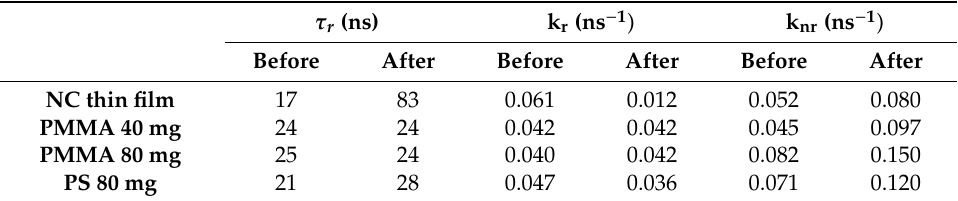
Table 1. Radiative lifetimes ( τ r ), radiative ( k r ) and nonradiative (k nr ) recombination rates, calculated for CsPbBr3 NCs thin film and PMMA- (40 mg and 80 mg load) and PS- (80 mg load) based free standing films before (values in black) and after (values in red) 280 h exposure to relative humidity RH% = 85 − 90% at 25 ◦ C. − 1 ) k − 1 ) τ r (ns) k r (ns nr (ns Before After Before After Before After NC thin film 17 83 0.061 0.012 0.052 0.080 PMMA 40